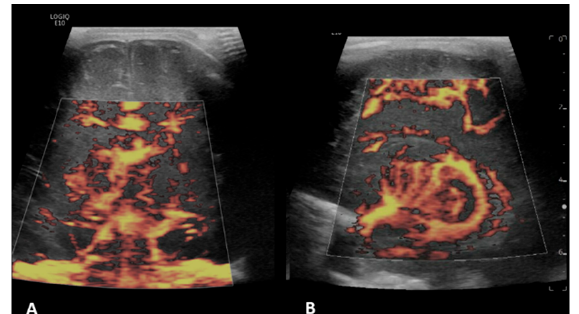
Figure 4. A 11-day-old boy with a history transposition of the great arteries (TGA) underwent ECMO due to failure to wean from cardiovascular bypass after major cardiac surgery. Brain MVI was performed after two days from cannulation; grayscale US (not shown) demonstrated diffuse/patchy hyperechogenicity in the white matter. Coronal ( A ) and right parasagittal ( B ) brain MVI of the basal ganglia and thalamic region demonstrated engorgement of the lenticulostriate microvessels, as well as heterogeneity and asymmetry. Table 1. Evaluation of microvessels in the BGT region with microvascular imaging ultrasound.